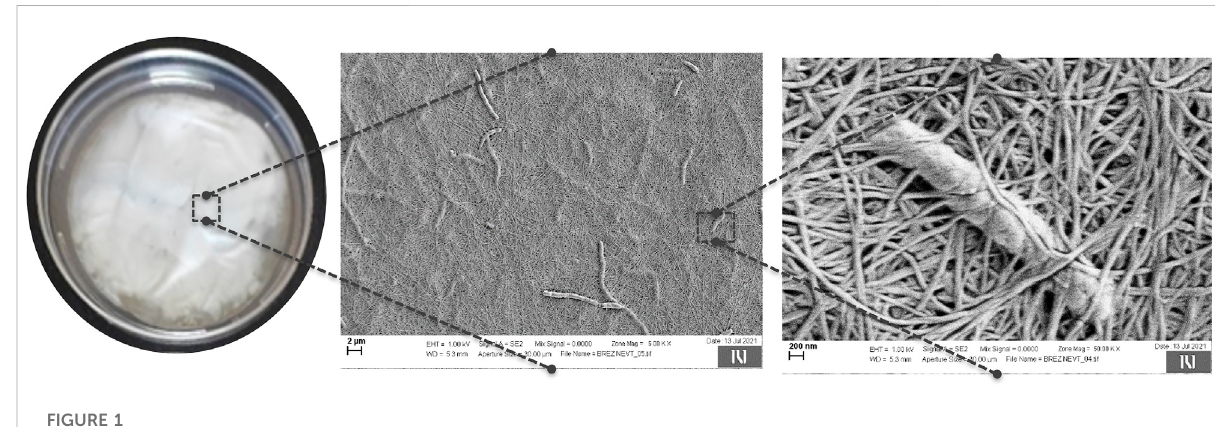
FIGURE 1 Bacterial cellulose network with entrapped cellulose producing